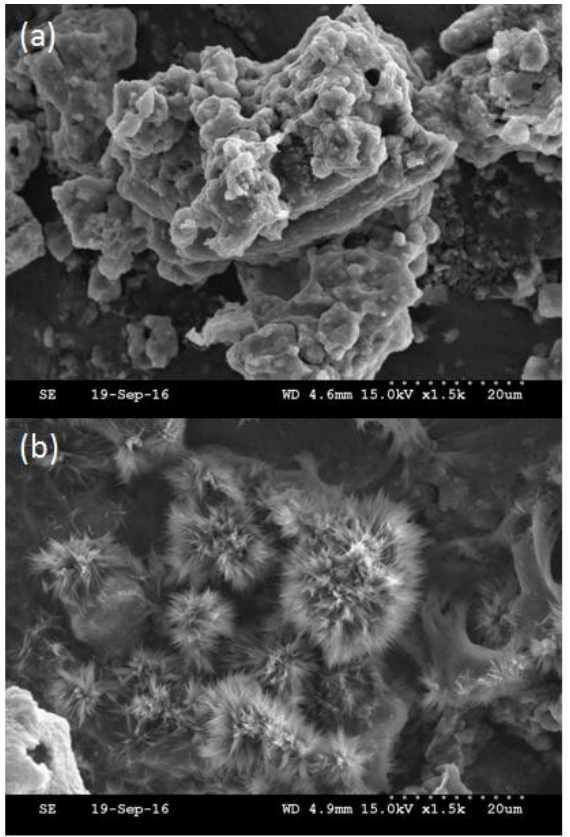
Figure 2. FE-SEM images of Fe 3 O 4 /MIPs ( a ) and DES-7-Fe 3 O 4 /MIPs ( b ).